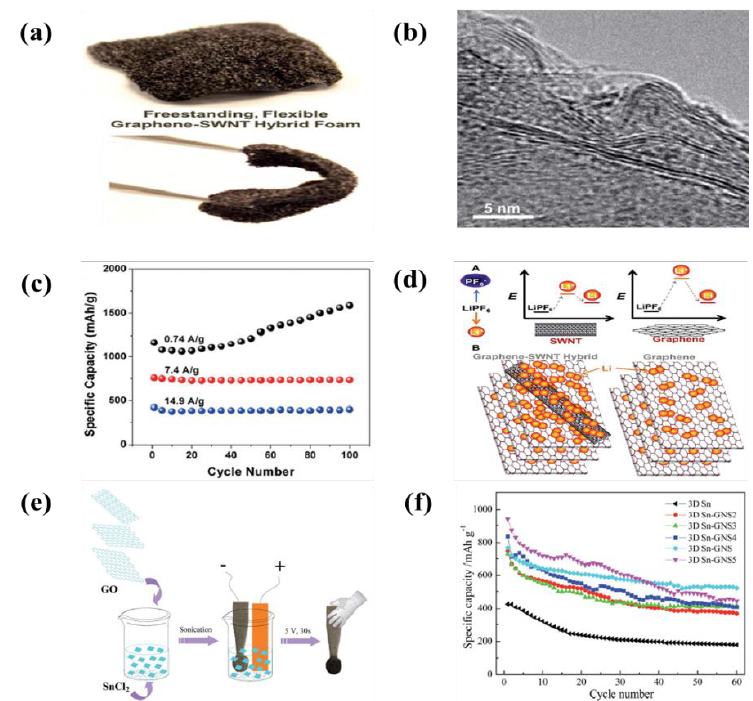
Figure 15. ( a ) Photograph of the 3D-porous graphene-SWCNTs electrode; ( b ) TEM image of the 3D-porous graphene-SWCNTs electrode; ( c ) Cycling performance of the 3D-porous graphene-SWCNTs electrode; ( d ) Schematic illustration of the improved capacity of the 3D-porous graphene-SWCNTs electrode; ( e ) Synthetic strategy illustration of the 3D-porous graphene/Sn composite electrode; ( f ) Cycling performance of the 3D-porous graphene/Sn composite electrode.